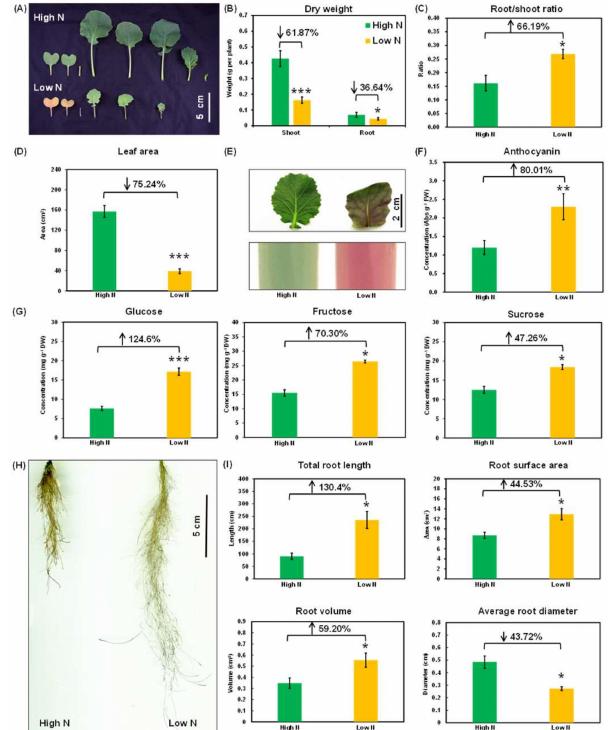
Figure 1. Morphological and physiological responses of rapeseed plants to nitrogen (N) limitations. ( A ) Leaf growth performance, ( B ) shoot and root dry weight, ( C ) ratio of root dry weight / shoot dry weight, ( D ) total leaf area, ( E ) leaf overaccumulating anthocyanin, ( F ) anthocyanin concentrations, ( G ) some carbohydrate (including glucose, fructose, and sucrose) concentrations in the leaves, ( H ) root growth performance, and ( I ) quantification of root system architecture of rapeseed plants that were hydroponically cultivated under N su ffi ciency and N limitation. Rapeseed plants after 7-day seed germination were hydroponically grown under high nitrate (6.0 mM NO 3 − ) and low nitrate (0.3 mM NO 3 − ) for 10 days, respectively. Columns denote means ( n = 5), and error bars indicate standard deviations. *, p < 0.05; **, p < 0.01; ***, p <